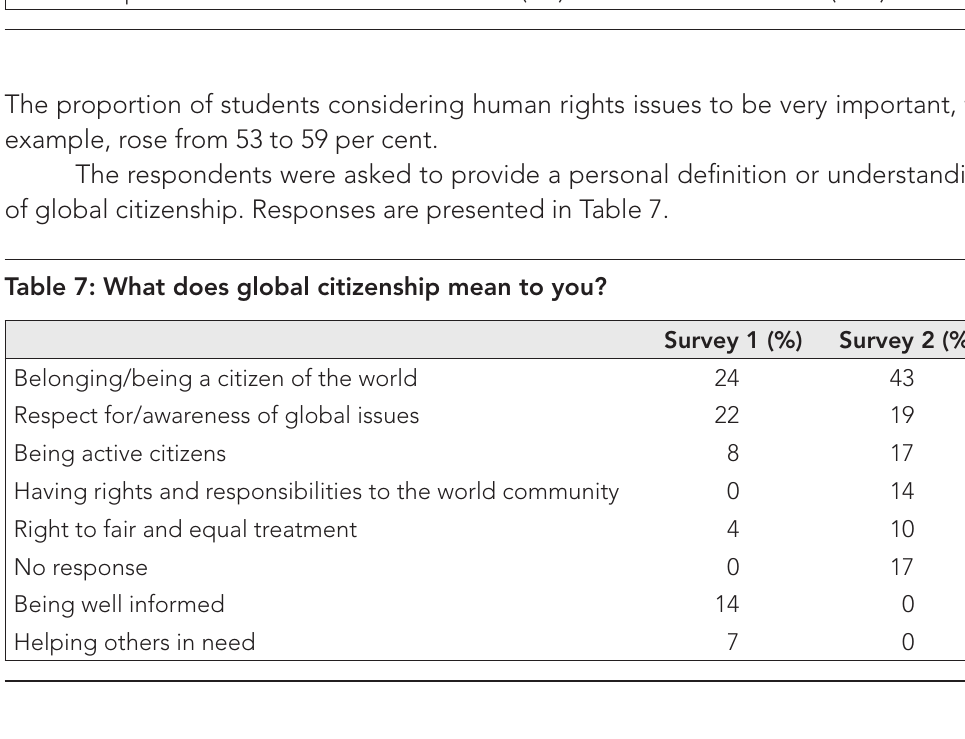
Table 7: What does global citizenship mean to you? Belonging/being a citizen of the world